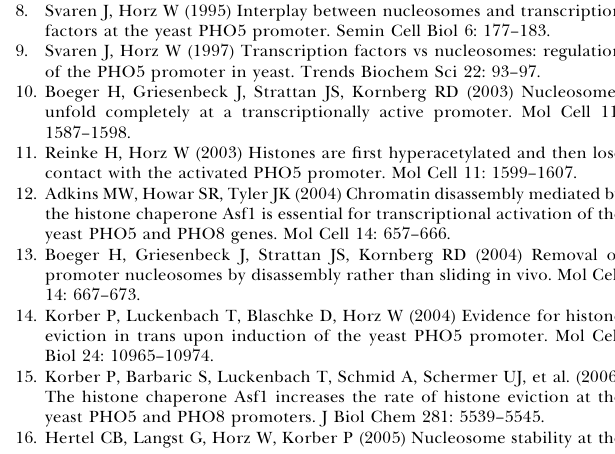
Figure S1. Nucleosome Occupancy at Bidirectional Cell Cycle– Regulated Promoters Varies with the Cell Cycle Same as Figure 6, but only the bidirectional promoters of cell cycle– regulated genes were analyzed. Found at DOI: 10.1371/journal.pgen.0020158.sg001 (97 KB PDF). Figure S2. Nucleosome Occupancy at Cell Cycle Gene Promoters (Left) Average profiles for unidirectional and bidirectional pro- moters of each cell cycle phase group. Solid lines represent average profiles, whereas dotted lines represent the 95% bootstrap con- fidence intervals. Bootstrapping with replacement was performed to derive 10,000 resamplings of the full sample size. (Right) Profiles of cycling and non-cycling promoters within each cell cycle group. Found at DOI: 10.1371/journal.pgen.0020158.sg002 (113 KB PDF). Figure S3. Relative Nucleosome Depletion Changes at the Promoters of Cell Cycle Regulators (A–C) z -Score values are plotted for the promoters of cell cycle regulators. The promoters were divided into groups (A–C) based on the cell cycle timing of regulation. The error bars are 6 standard error of the mean (SEM). Both unidirectional and bidirectional promoters are plotted.